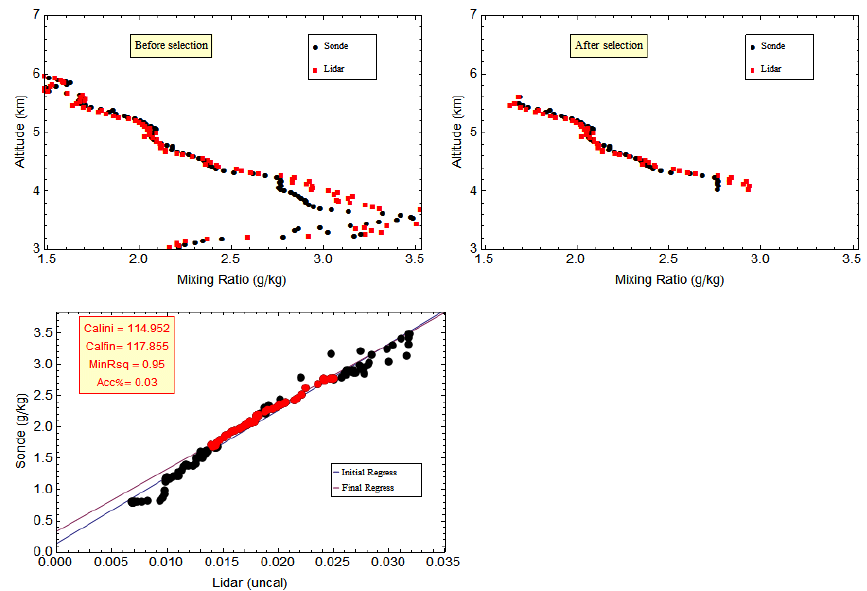
Fig. A6. Demonstration of the adaptive radiosonde calibration routine. In the upper left is shown both lidar (red) and radiosonde (black) profiles without data filtering. In the upper right is shown the sets of ordered pairs that are selected by the algorithm described in the text. On the bottom is shown the regression lines of the original set of lidar and sonde ordered pairs in black and the finally selected set in red.